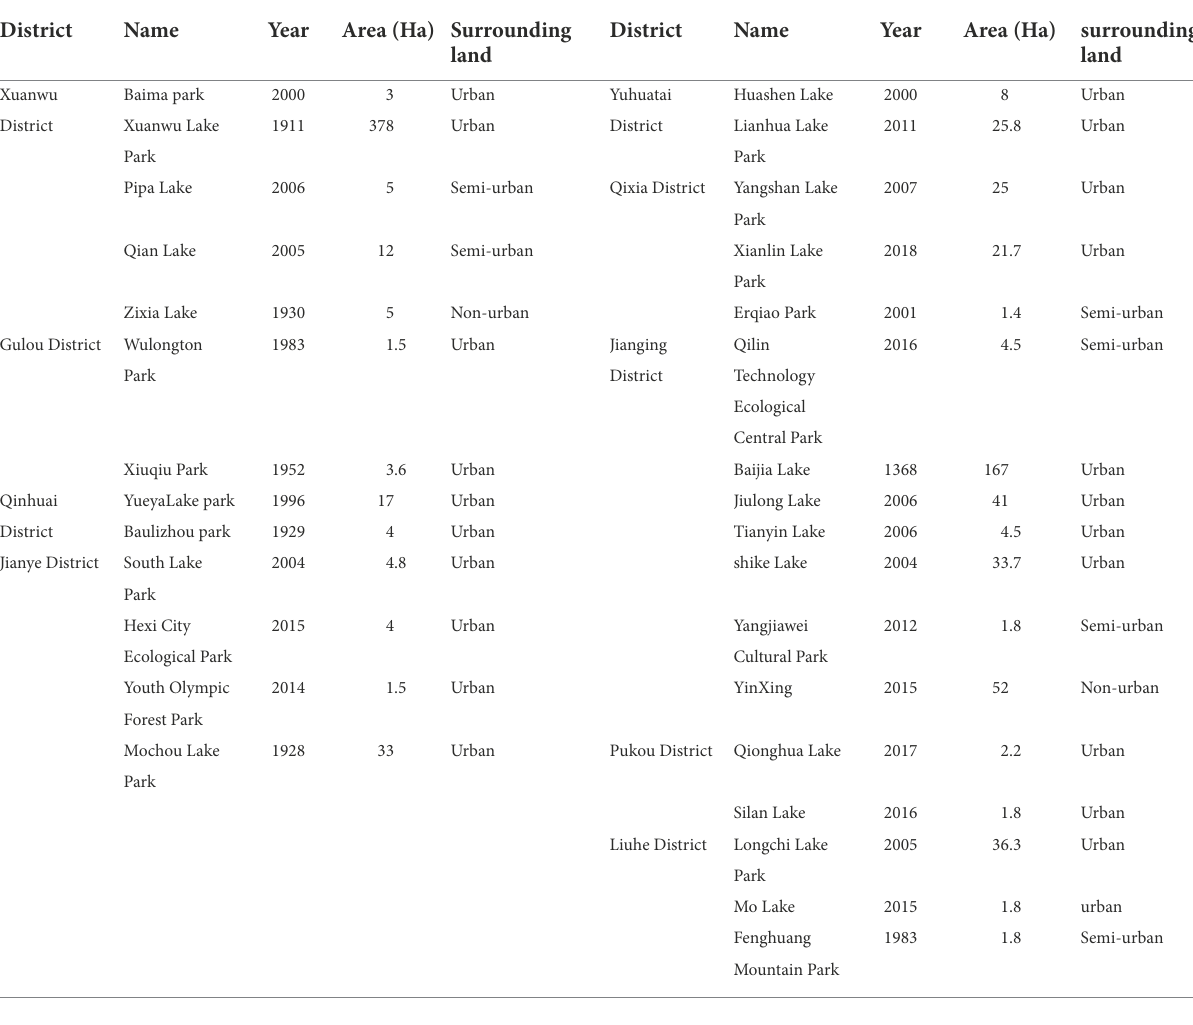
TABLE 1 Summary of research